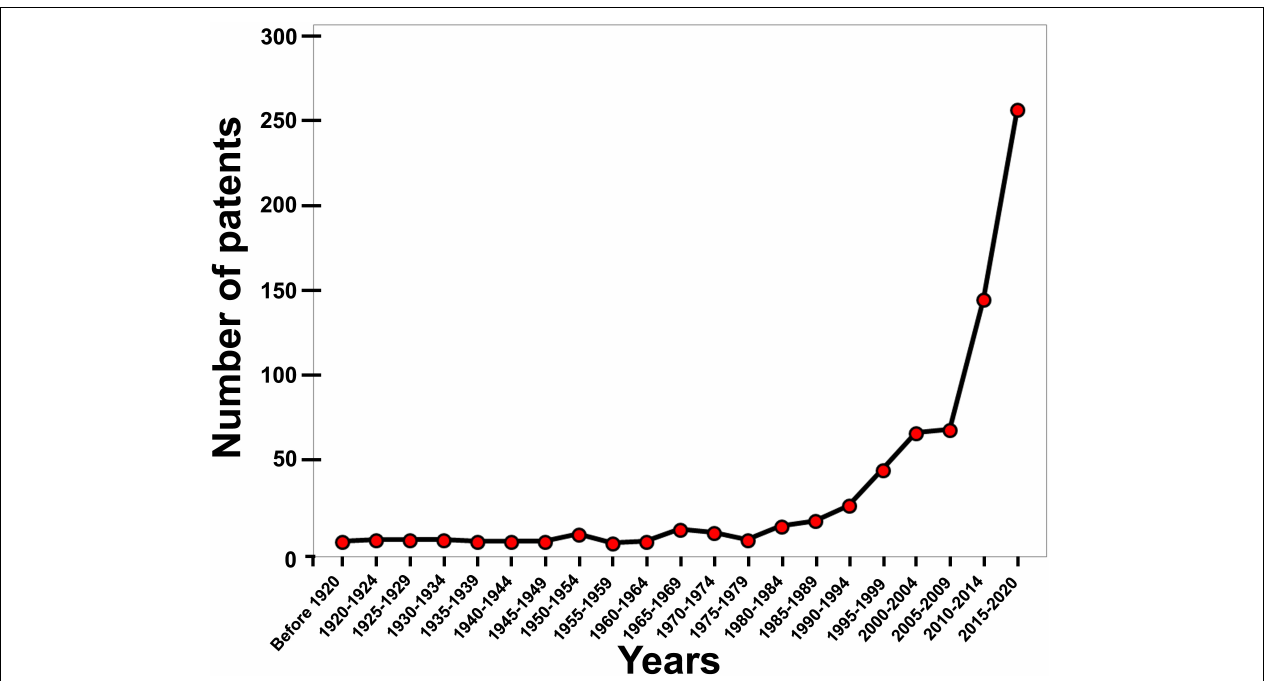
FIGURE 2 | Chronology for patents describing ES-related devices and methods in the last century. An exponential increase in patent numbers in the last two decades is apparent (Data derived from the Google patent research engine).